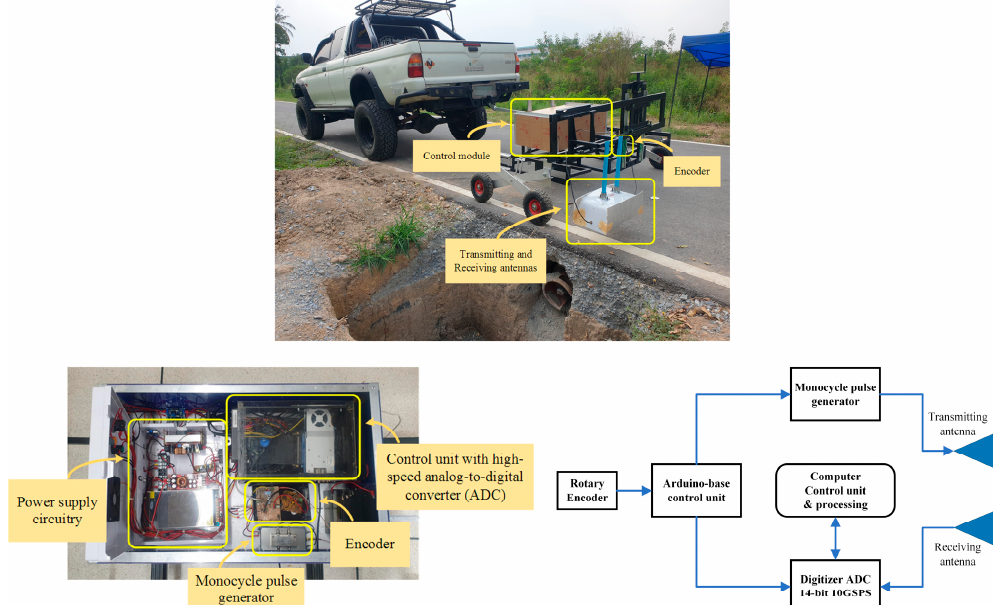
Figure 6. Implemented hardware for GPR.